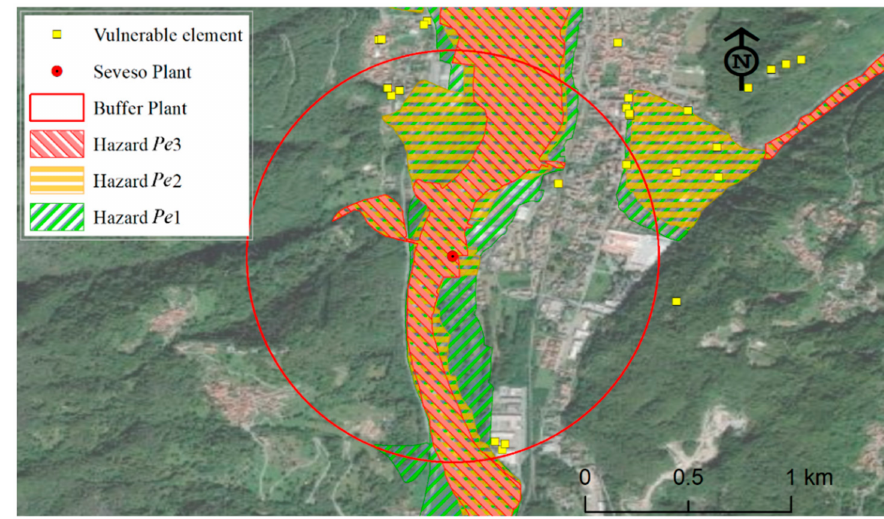
Figure 6. Example of buffer area including vulnerable items potentially exposed to Na-Tech risk in case of flood hazard for Pe 1, Pe 2 and Pe 3.